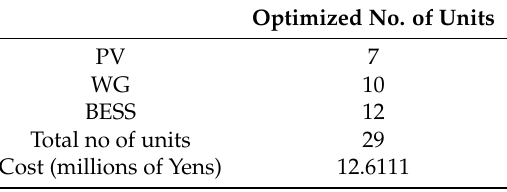
Figure 7. Scenario 2 results. Table 3. Scenario 2 results.